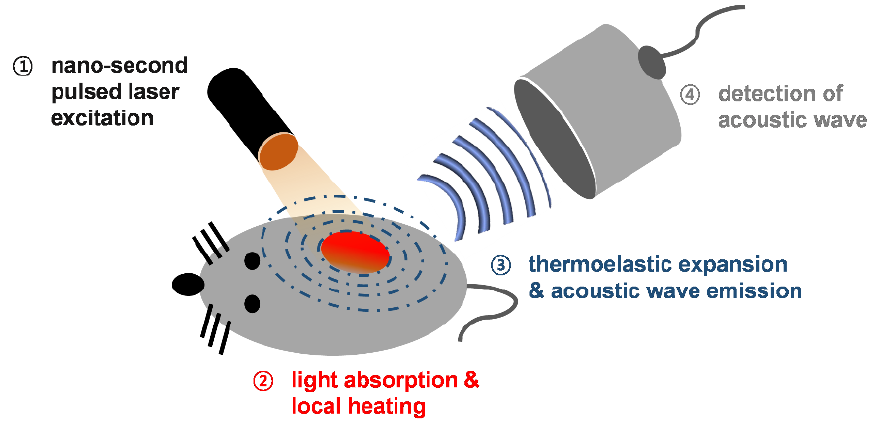
Figure 1. Schematic of the basic principles of photoacoustic imaging. The endogenous PA contrasts in the living body help to achieve diverse contrast in molecular PA imaging of individual organs and biological components, but the insensitivity to low concentrations of biomolecules and their absorption of visible light limits the ability to provide strong PA signals from deep tissues [34]. In addition, white and transparent organs, such as the intestines, lymph nodes, and bladder cannot produce sufficient PA signals because of their extremely low light absorption. Therefore, there has been an ongoing need for exogenous PA contrast agents to achieve high PA sensitivity, deep tissue imaging, and specific targeting of non-pigmented organs [35–40]. A variety of materials have been used as the exogenous contrast agent, including small-molecule chromophores, π -conjugated polymer-type organic semiconductors, gold nanoparticles, or organic-inorganic hybrid materials, and they have shown the PA imaging capability along with desired properties such as biotic degradation, biodistribution, or renal clearance as summarized before [41]. Meanwhile, carbon-based nanomaterials have attracted attention owing to their unique shape, extended π -conjugation, synthetic flexibility for surface engineering, large surface area, or interesting photophysical properties, which are of the main focus of this review paper as shown